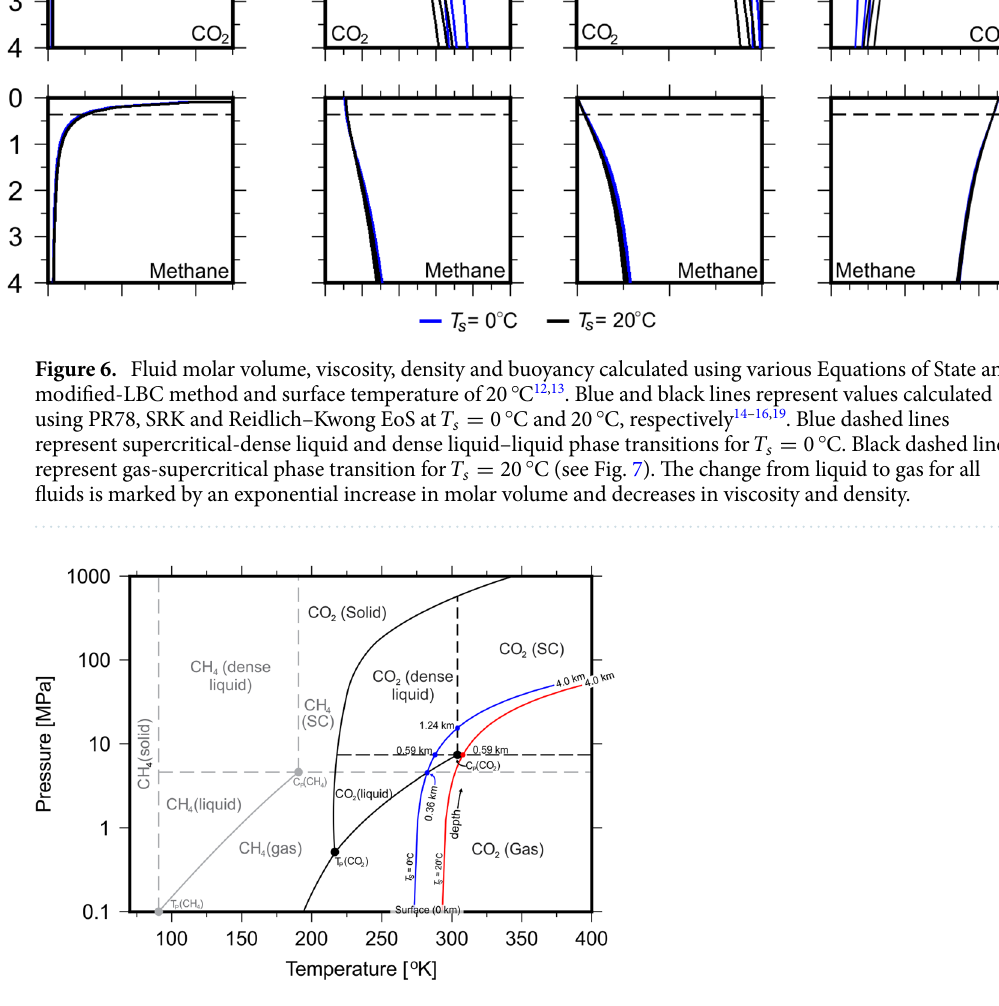
Figure 7. Phase diagram for CO 2 , methane calculated at normal geological conditions and geothermal gradient = 25 ◦ C/km. Blue and red lines represent PT paths calculated at T s = 0 ◦ C and 20 ◦ C, respectively. Black lines and points represent phase diagram for CO 2 . grey lines and points represent the phase diagram for methane. T p = triple point, C p = critical